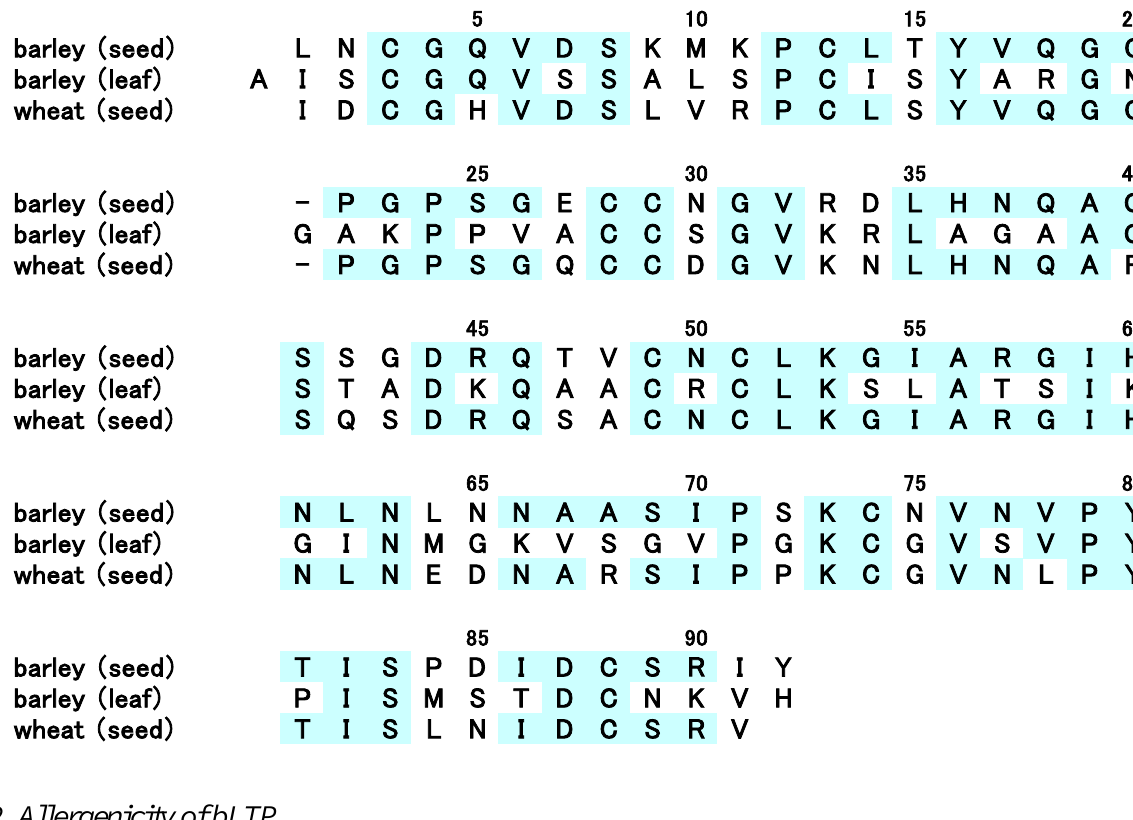
Figure 1. Deduced amino acid sequences of barley seed and leaf lipid transfer proteins (LTPs) and wheat seed LTP from their nucleotide sequences (NLT1_HORVU, 15 NLT3_HORVU, and NLTA_WHEAT). The blue highlight indicated the homologous amino acid in the alignment of these amino acid